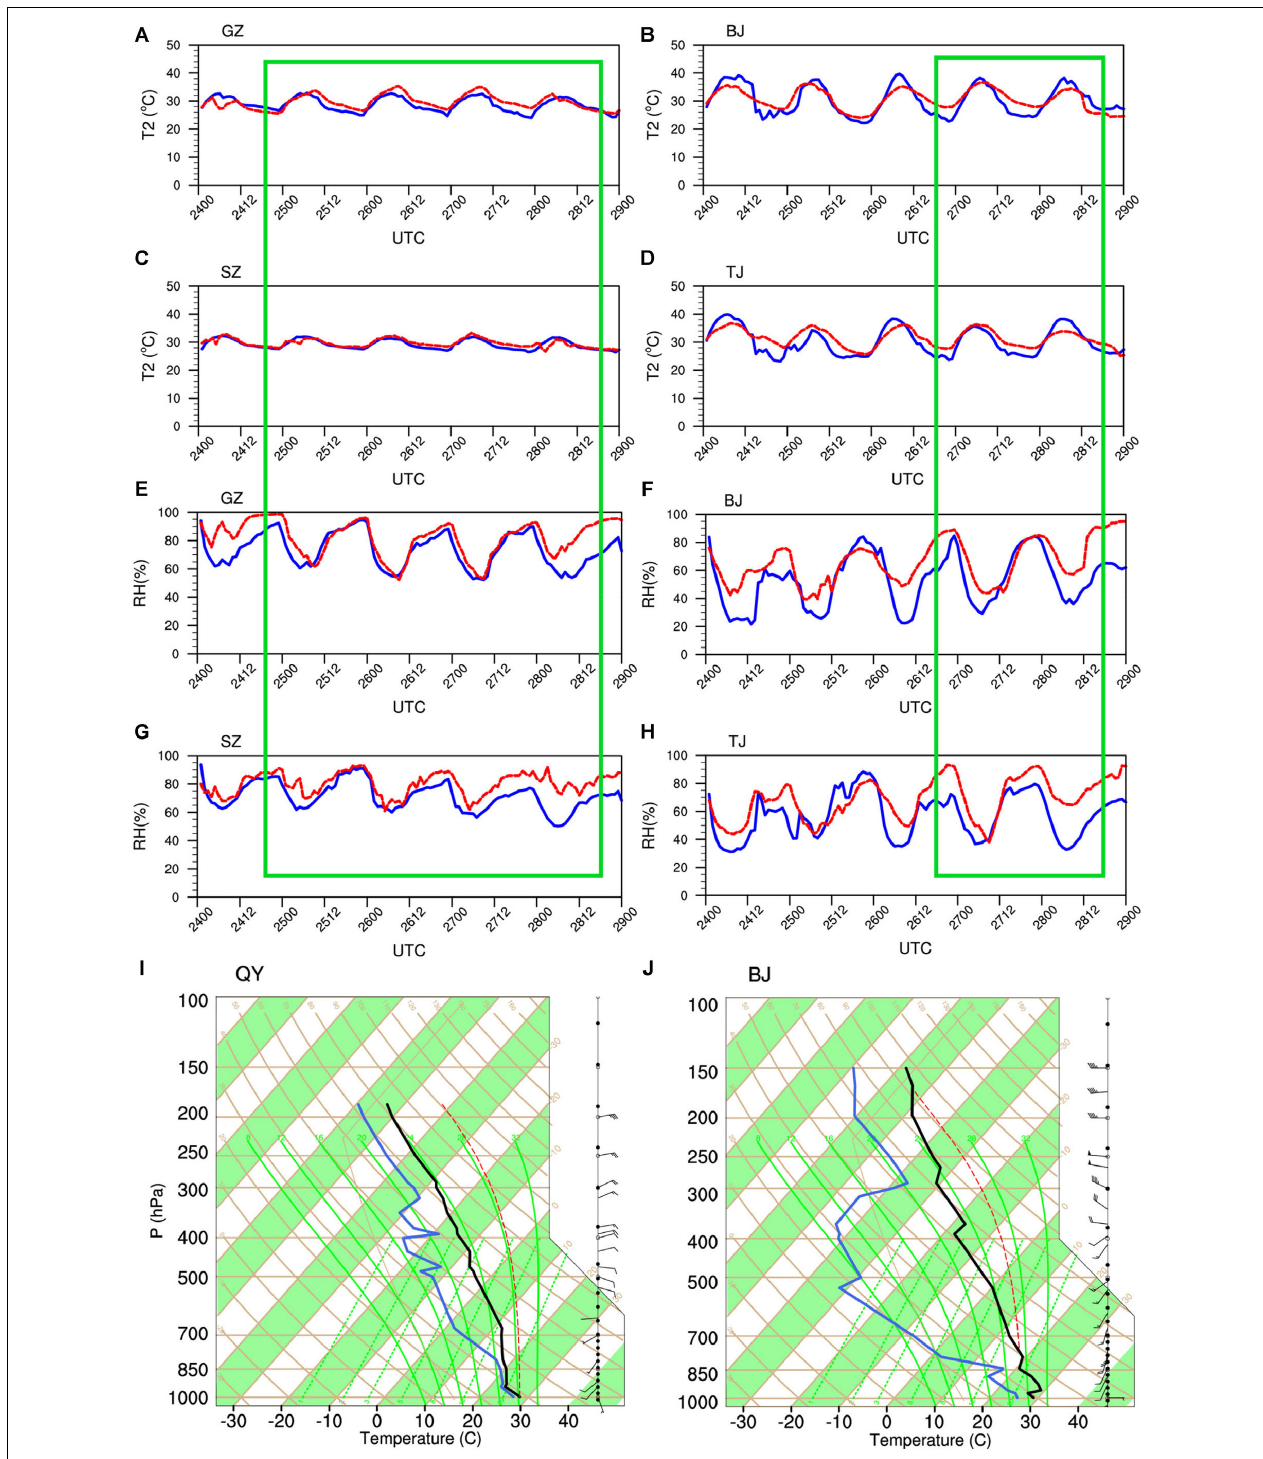
FIGURE 2 | (A–H) Observed (red) and simulated (blue) 2-m air temperature ( ◦ C) and relative humidity (%). The green frames show the heat stress episodes in south and north cities. Sounding plots in panels (I) Qingyuan (QY) and (J) Beijing (BJ) stations, denote observations in south and north, with black and blue curves representing temperature and dew point,